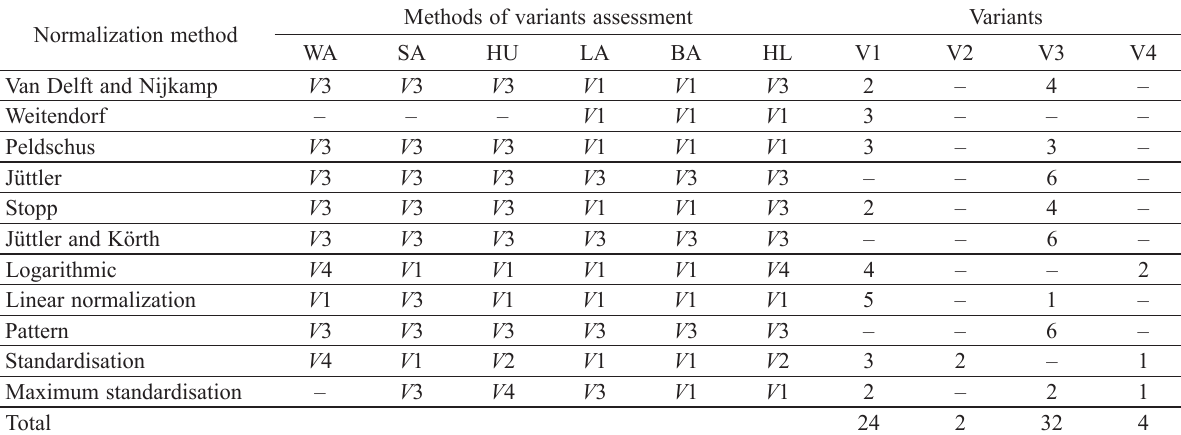
Table 6. A summary of the most beneficial variants Normalization